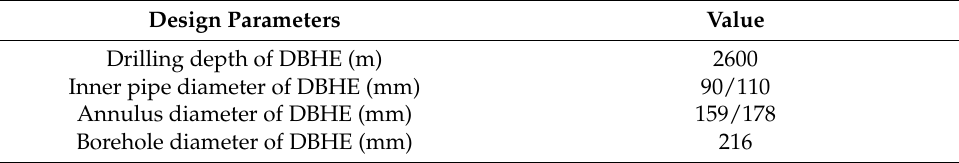
Table 2. Design parameters of the deep